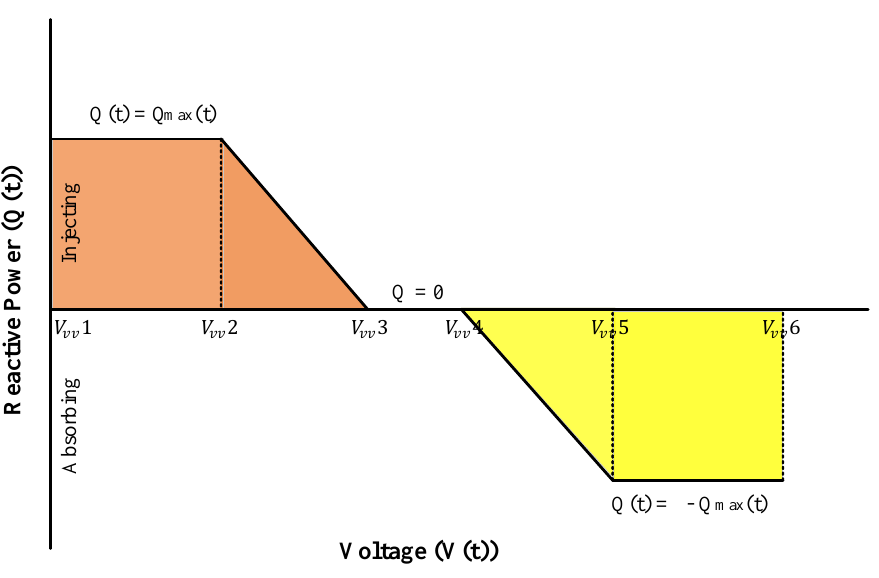
Figure 3. Volt – Var curve characteristics. Figure 3. Volt–Var curve